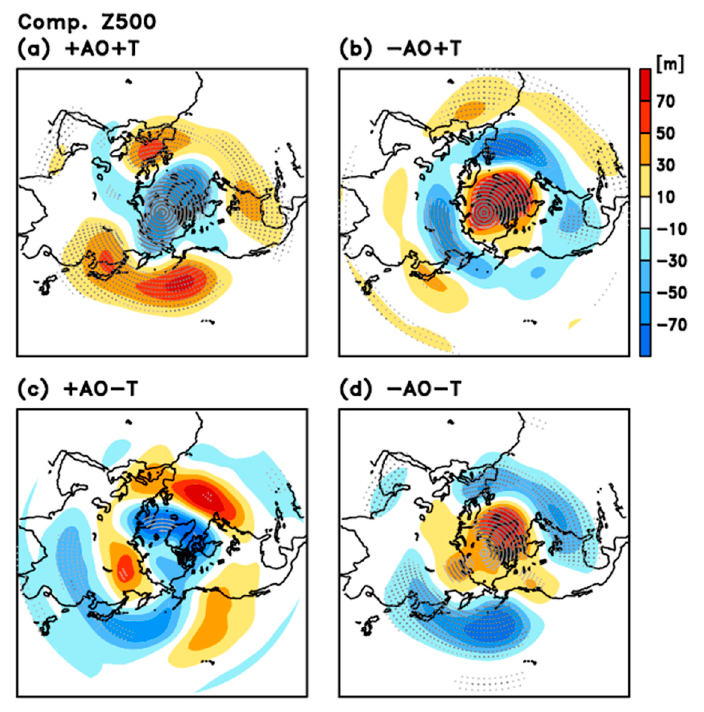
Figure 2. Composite maps of geopotential height anomalies at 500 hPa in winter season for ( a ) +AO+T, ( b ) − AO+T, ( c ) +AO − T, and ( d ) − AO − T group. Light (dark) gray dots denote grid points which satisfy 90% (95%) confidence level through the two-tailed Student’s T-test.